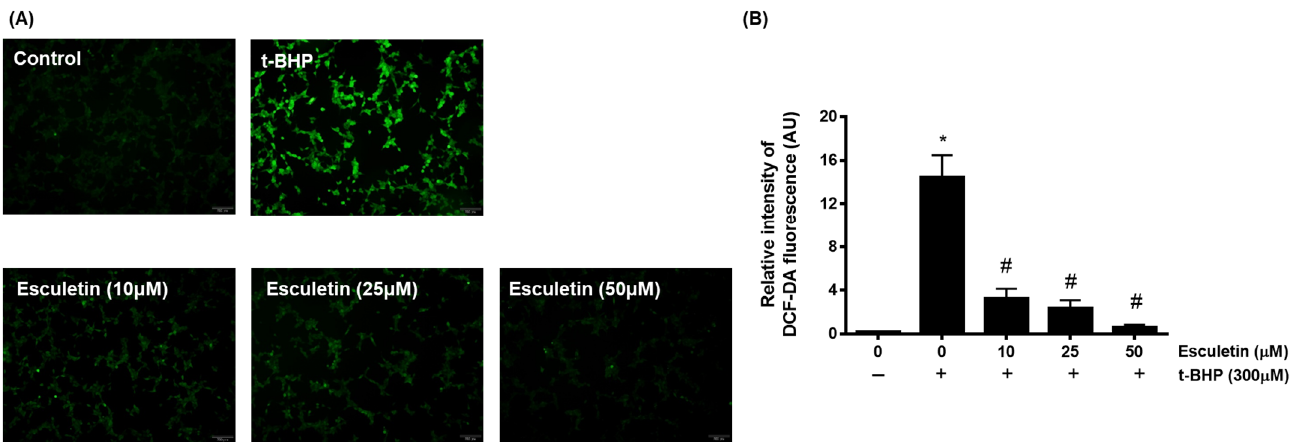
Figure 2. Effect of esculetin on t-BHP-induced ROS generation in HEK293 cells. ( A ) The changes in ROS levels in HEK253 cells exposed to t-BHP with esculetin were detected using DCFH-DA dye. ( B ) In the bar graphs, the values represent means ± SD, n = 5. * p < 0.05 vs. untreated control group, # p < 0.05 vs. t-BHP-treated group.